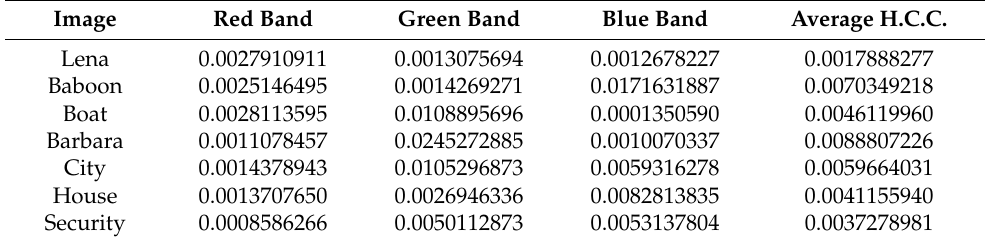
Table 4. Horizontal correlation coefficient results.